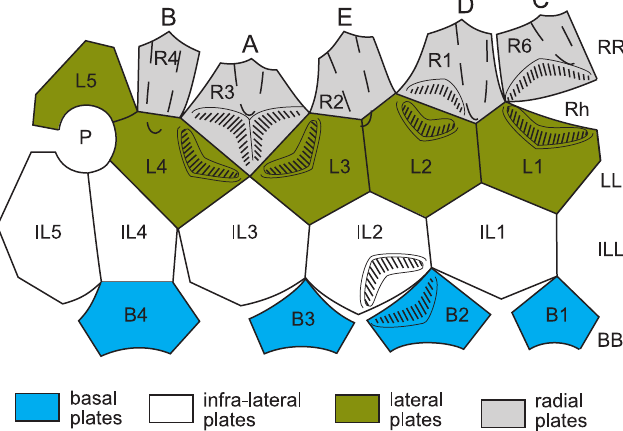
Fig. 9. Thecal plating in the callocystitid Lepadocystis moorei (Meek, 1871), Late Ordovician, Ohio, USA, illustrating typical extraxial plate arrangement in callocystitid and glyptocystitoid rhombiferans. Plates are arranged in four circlets, basals (B, BB), infra-laterals (IL, ILL), laterals (L, LL), and radials (R, RR), plus the orals which are largely axial in origin (see Fig. 5). All glyptocystitoids have four BB, five ILL and LL, and originally six RR. In all callocystitids R5 is absent. In Lepadocystis L5 interrupts the radial cir- clet and the periproct (P) is surrounded by four plates, IL4, IL5, L4, and L5. Lepadocystis has five, short ambulacra (dashed outlines below letters A–E) on the thecal plates and five pectinirhombs (Rh) across plate sutures